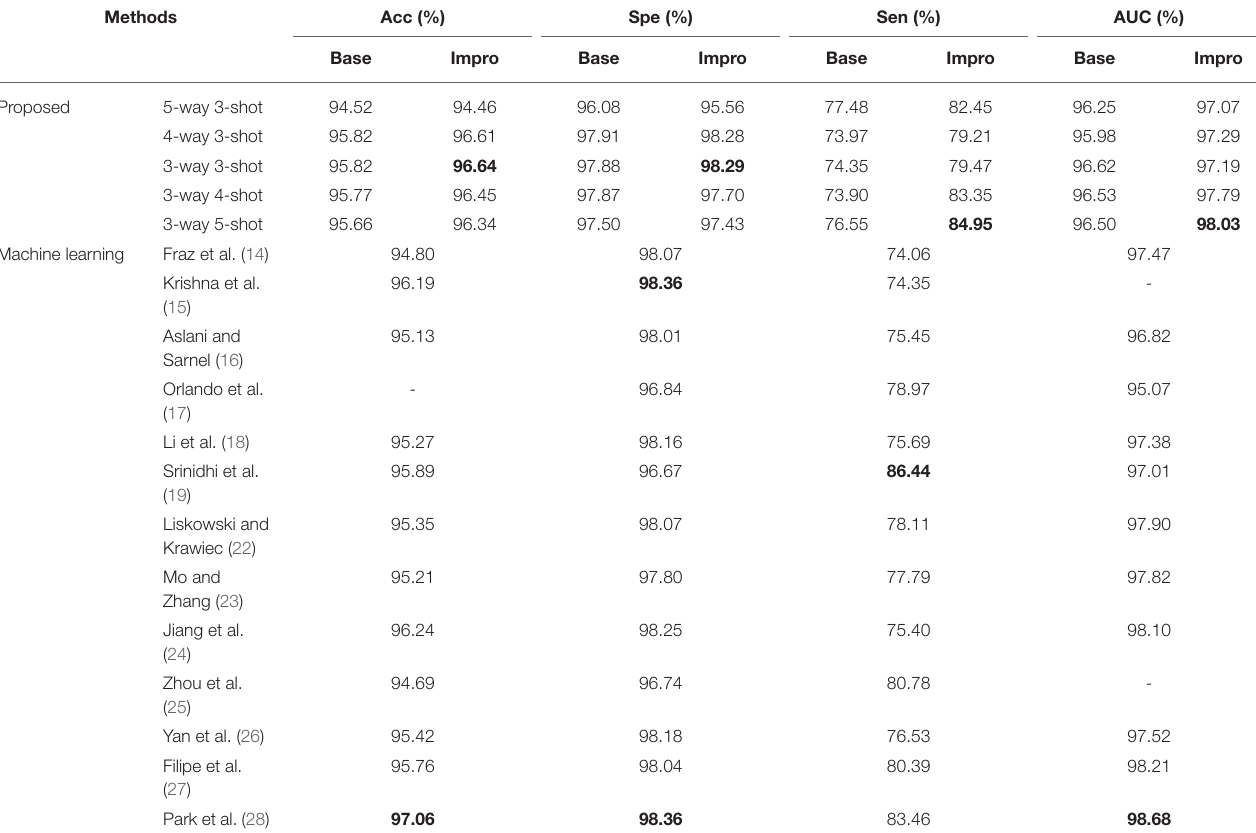
TABLE 2 | Performance comparison on DRIVE.